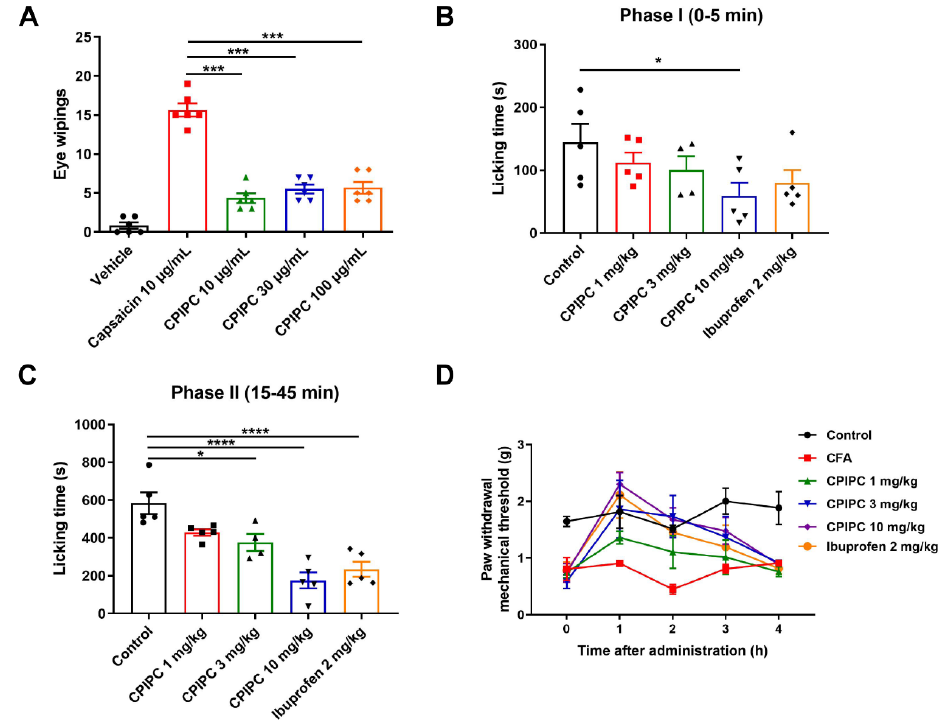
Figure 6. Pungency and antinociception of CPIPC in mice. ( A ) Effect of capsaicin (10 µ g/mL) or CPIPC (10, 30 and 100 µ g/mL) on the number of wiping movements evoked by instillation of 10 µ L different solutions into mouse left eyes. Number of eye wipes was counted for 60 s after application of the compounds ( n = 6). Statistical difference between the capsaicin and CPIPC groups is indicated as *** p < 0.001 by one-way ANOVA and post hoc Bonferroni’s test. ( B , C ) Anti-nociceptive effects of CPIPC on licking of inflammatory pain induced by intraplantar injection of formalin (5% formalin in vehicle saline) in the hind paw ( n = 5). Phase I and II referring to the sum of licking time from 0 to 5 min and 15 to 45 min after the injection of formalin. Ibuprofen (2 mg/kg) and CPIPC (1, 3, 10 mg/kg) were pre-administered for 1 h before the intraplantar injection of formalin. Statistical difference between the vehicle control and administration groups is indicated as * p < 0.05, **** p < 0.0001 by one-way ANOVA and post hoc Bonferroni’s test. ( D ) Antinociceptive effects of CPIPC on inflammatory pain induced by intraplantar injection of 20 µ L CFA (50% in saline) ( n = 6). The paw withdrawal mechanical threshold (PWMT) of mice was measured after intraplantar injection of CFA for 24 h by von Frey hair. PWMT was measured at 0, 1, 2, 3, 4 h after oral administration of ibuprofen (2 mg/kg) and CPIPC (1, 3, 10 mg/kg). Statistic difference between the vehicle control and different doses of CPIPC groups is presented in Table 1.